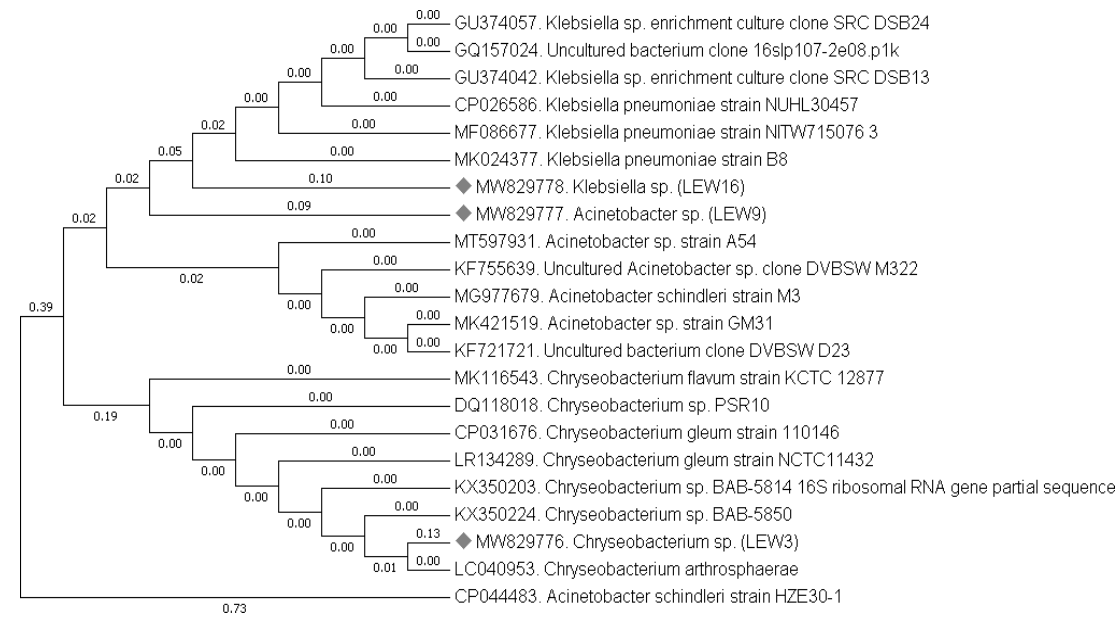
Figure 5. Neighbor-joining phylogenetic tree of Chryseobacterium sp. (LEW3), Acinetobacter sp. (LEW3), and Klebsiella sp. (LEW16) constructed by closely related taxa.